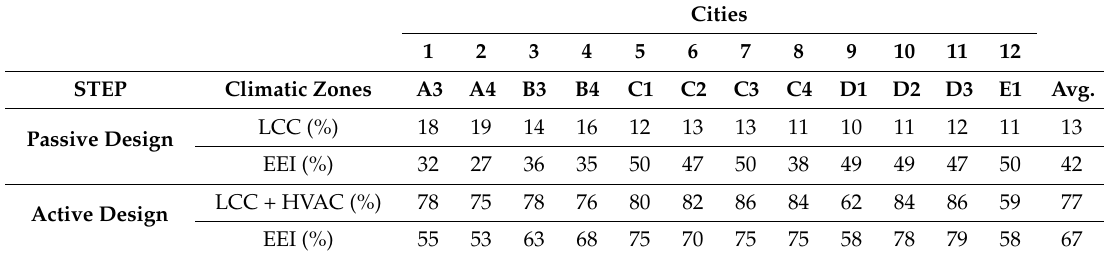
Table 7. Percentage of reduction of LCC and EEI with respect to the building initially designed.